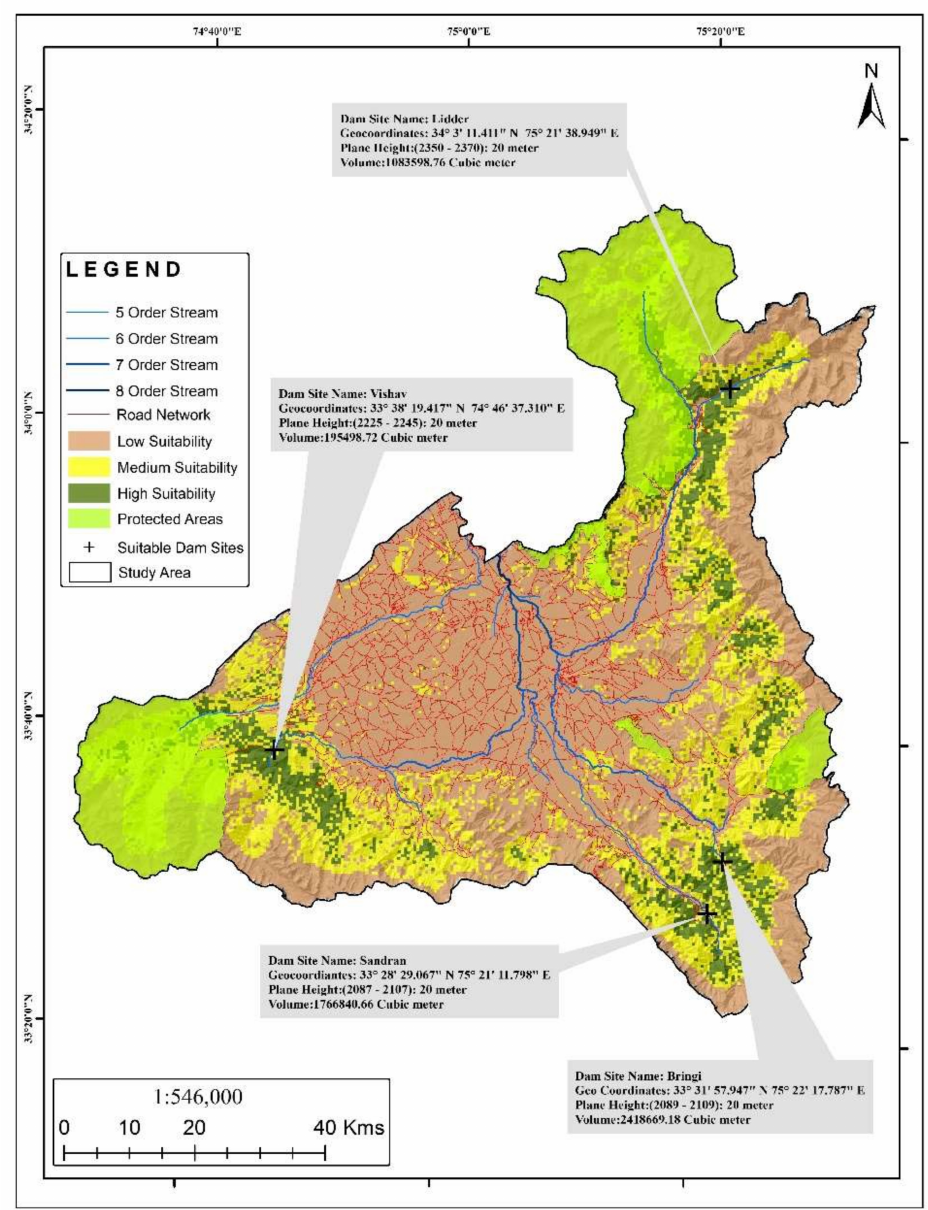
Figure 6. Suitable site for dam